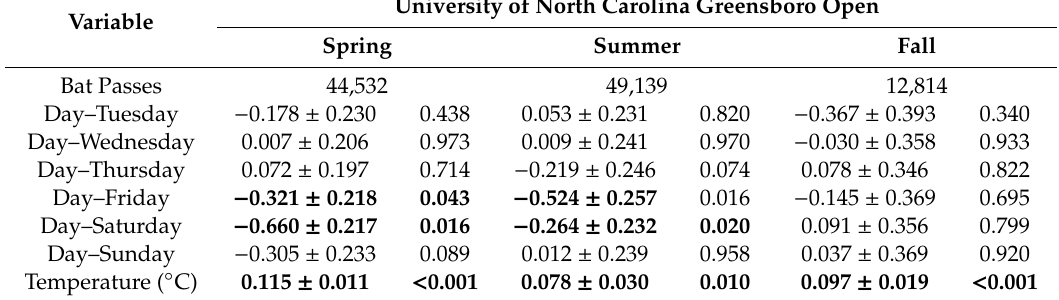
Table 2. Numbers of total bat passes (including no species identification) collected in 2018 and 2019 springs, summers, falls and generalized linear model results (total bat passes versus day of the week and environmental covariates, regression estimate ± standard error and p value reported) by season at the University of North Carolina Greensboro sites in Greensboro, North Carolina, USA. “NA” indicates variables dropped from the final model. Bold numbers indicate significant